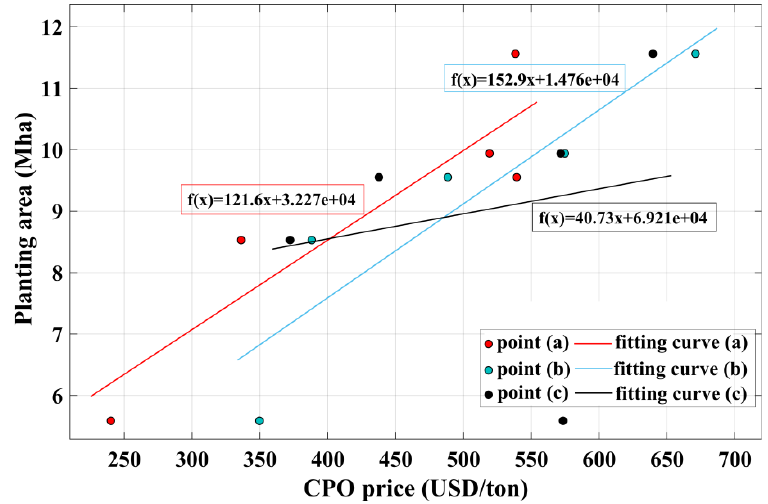
Figure 11. The curve fitting of the crude palm oil (CPO) price and oil palm planting area. Points refer the oil palm planting area vs. the price of CPO; fitting curve represents the fitting result of the oil palm planting area and the price of crude palm oil. ( a ), ( b ), and ( c ) refer the current year, previous year, and previous two years, respectively.